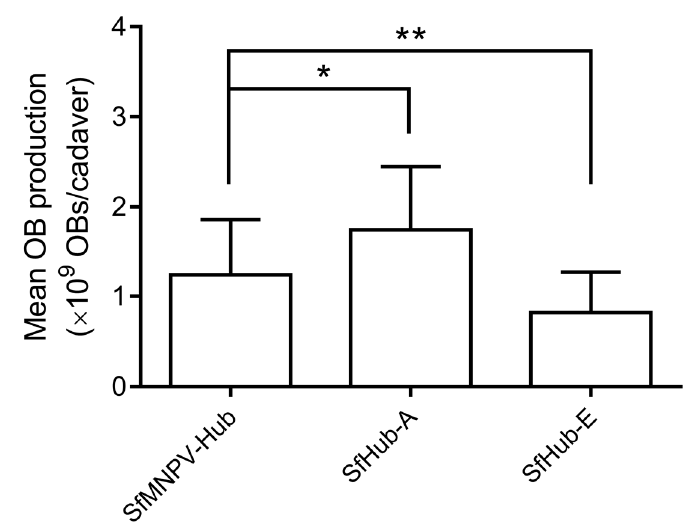
Figure 5. OB production of SfMNPV field isolate and genotypes in the S. frugiperda larvae. OB numbers in 39, 25, and 37 cadavers killed by SfMNPV-Hub, SfHub-A, and SfHub-E were counted. Error bars represent the SD. * represents p < 0.05, ** represents p < 0.01 by Dunnett’s test.